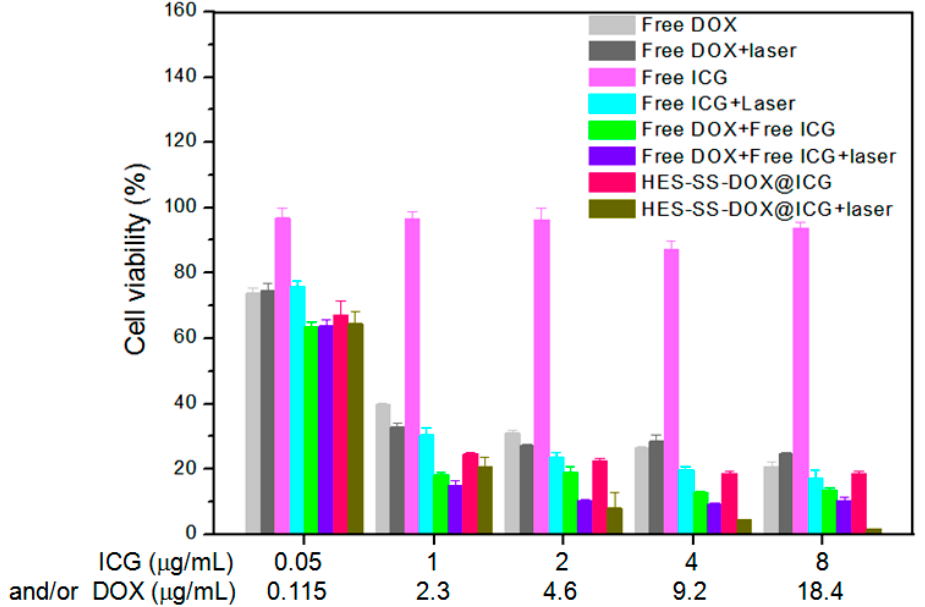
Figure 4. Viability versus ICG concentration for HepG2 cells treated with free DOX, free ICG, free DOX + free ICG, and HES-SS-DOX@ICG NPs with or without laser irradiation (culture time: 24 hours, irradiation intensity, and time for all involved cases were 0.75 W/cm 2 and 5 minutes).